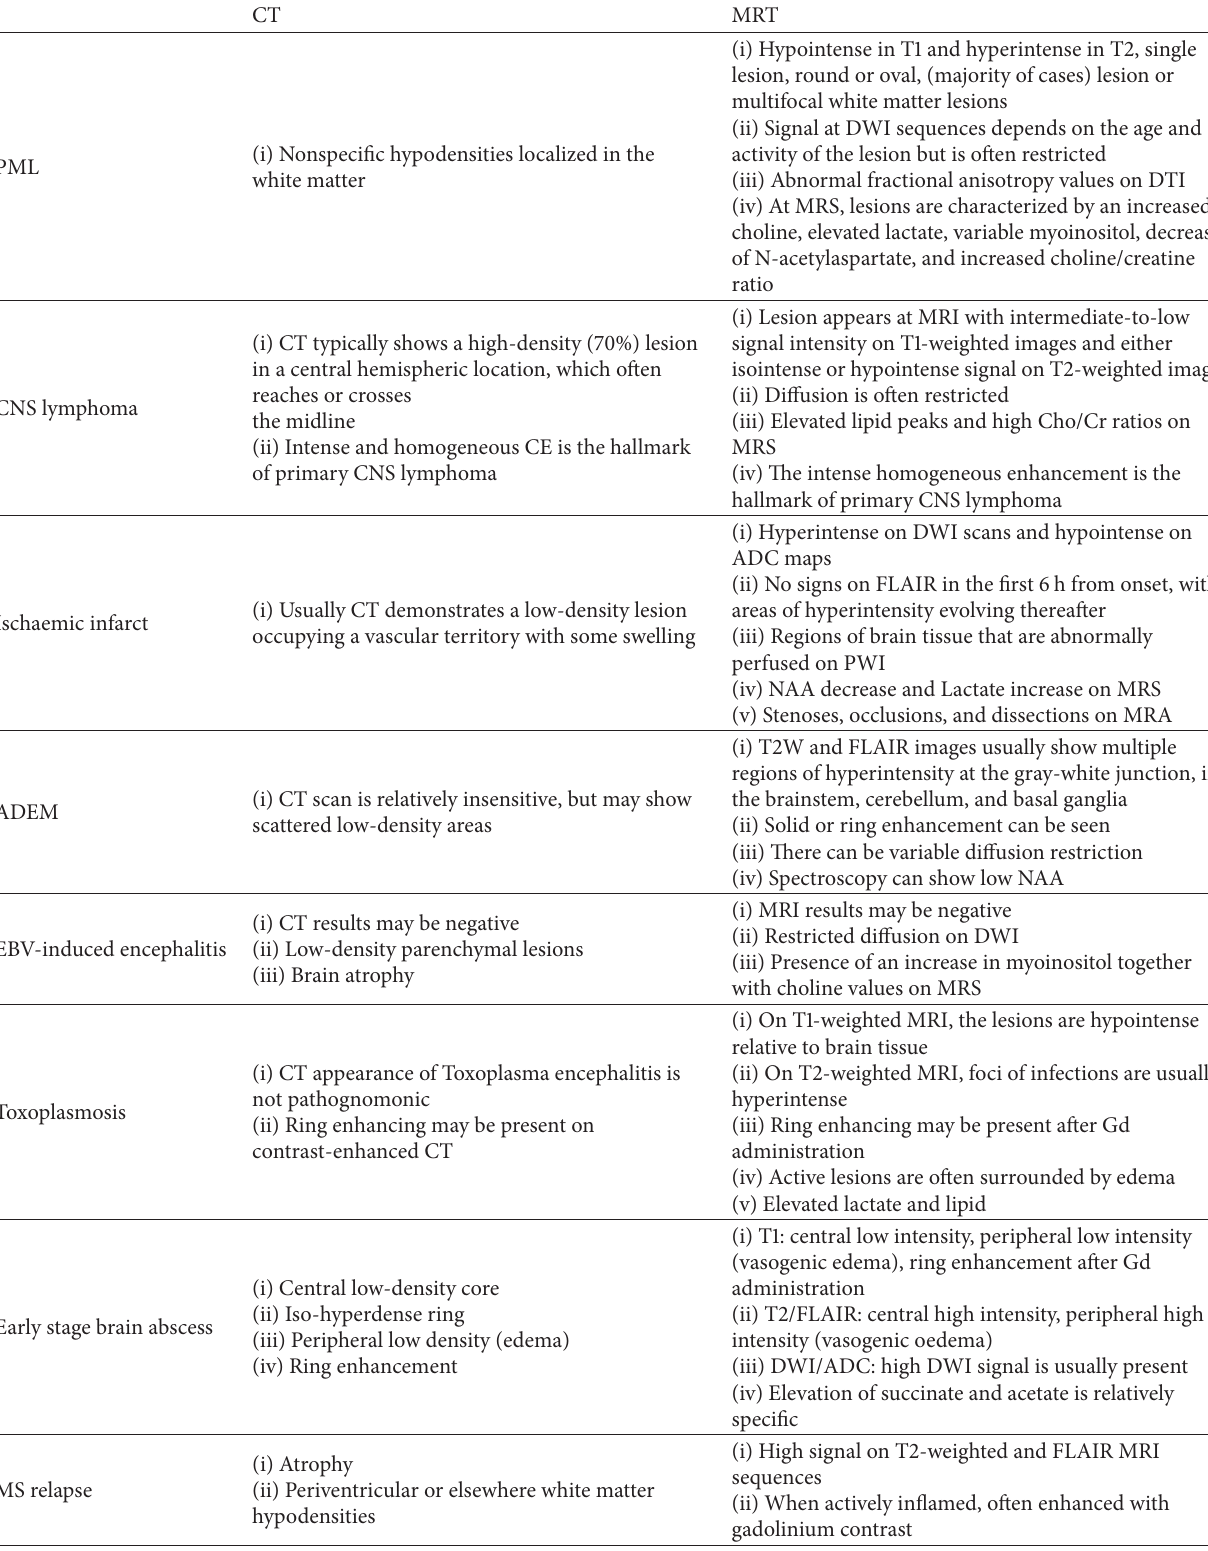
Table 1: Differential diagnosis of